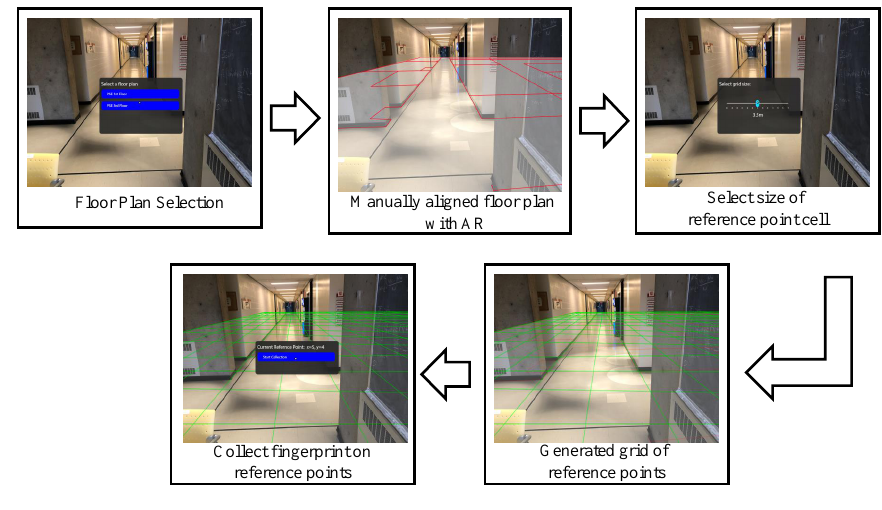
Figure 3. The user interface of AR application for aligning floor plan with indoor space and generating reference point grid for